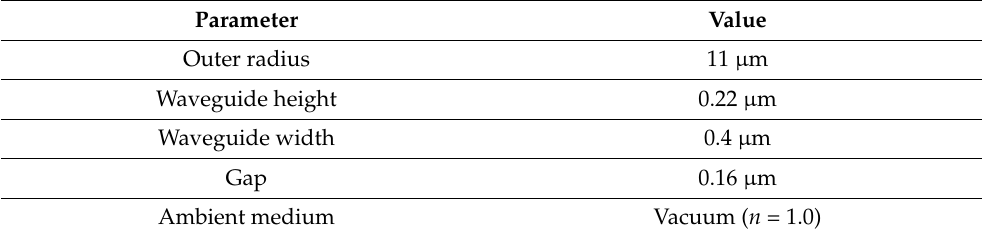
Table 2. Add-drop MRR sensor